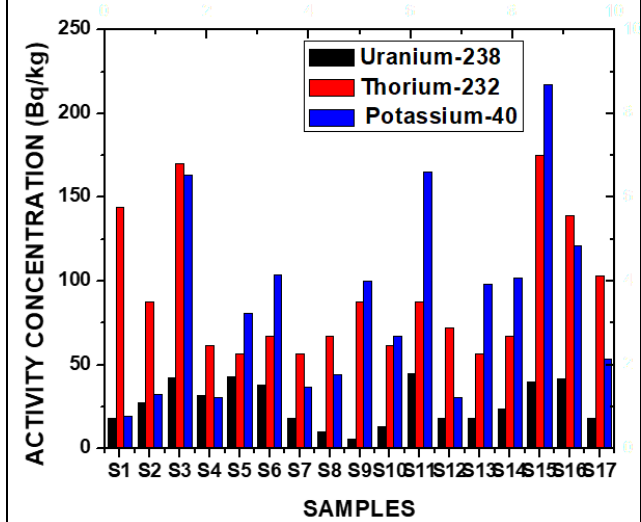
Figure 2: Graphical representations of activity concentrations of the radionuclides in this study. Source: Authors,